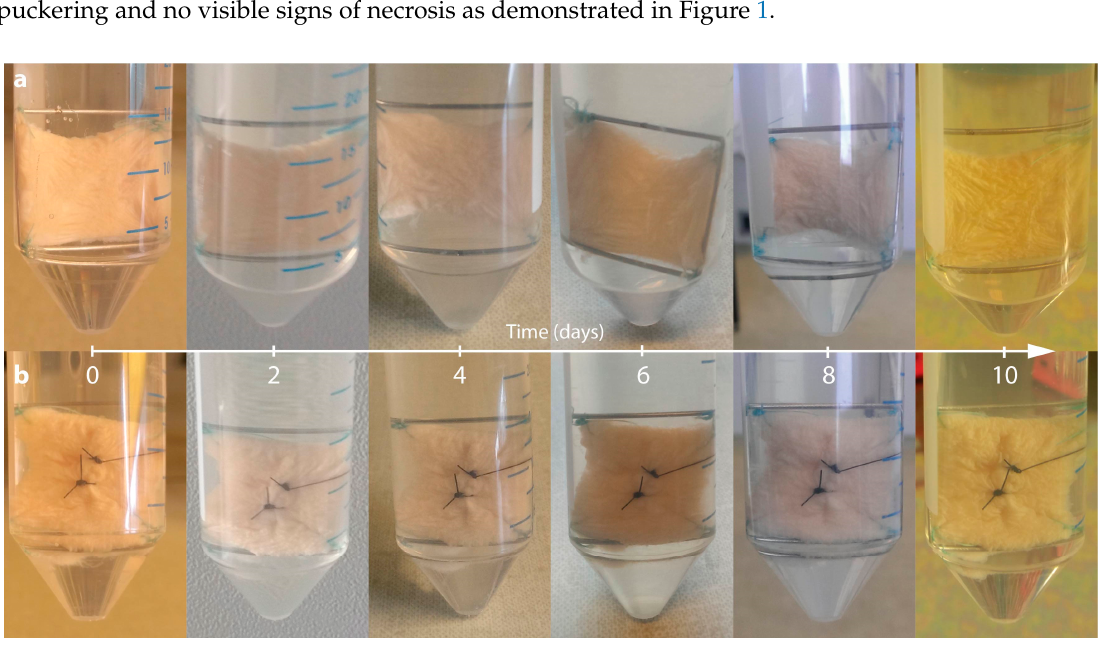
Figure 1. Photo coverage of full-thickness skin grafts of patient 1 (20 × 20 mm) fixed on frames made of surgical steel immediately after preparation (0 day). Pictures show samples immediately after explant dissection, as well as at 2, 4, 6, 8 and 10 days after mounting. All explants belong to the same donor. Non-wounded ( a ) and wounded simple interrupted sutured samples ( b ) are shown. No sample shows signs of necrosis, inflammation or disintegrated tissue.